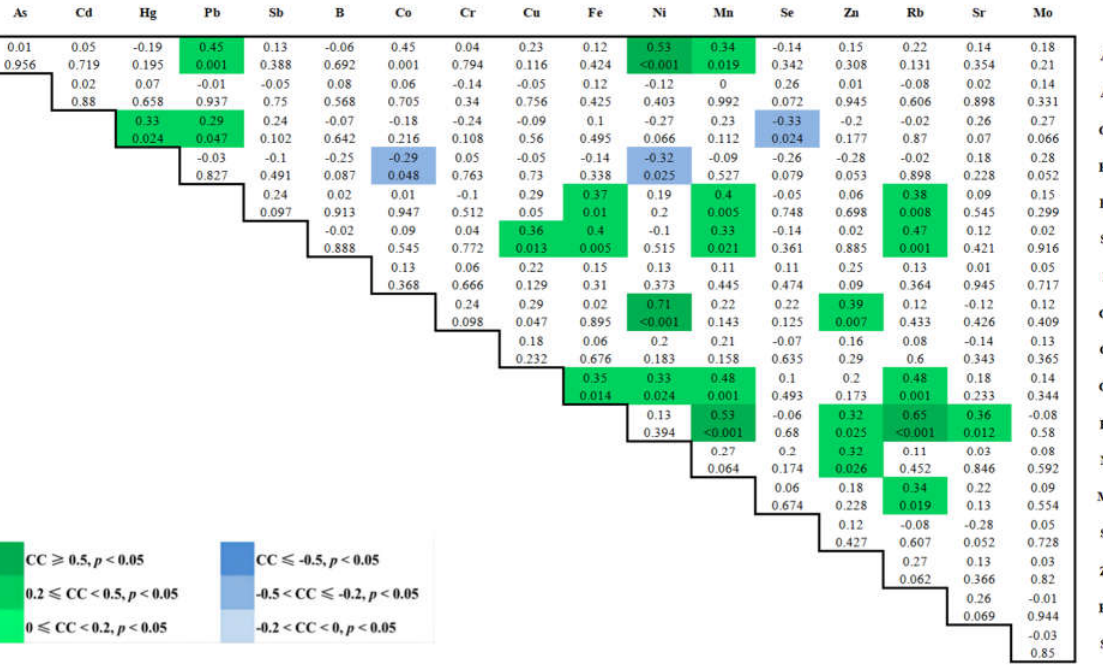
Figure 5. Color map of the Spearman correlations between 18 elements in cord plasma.